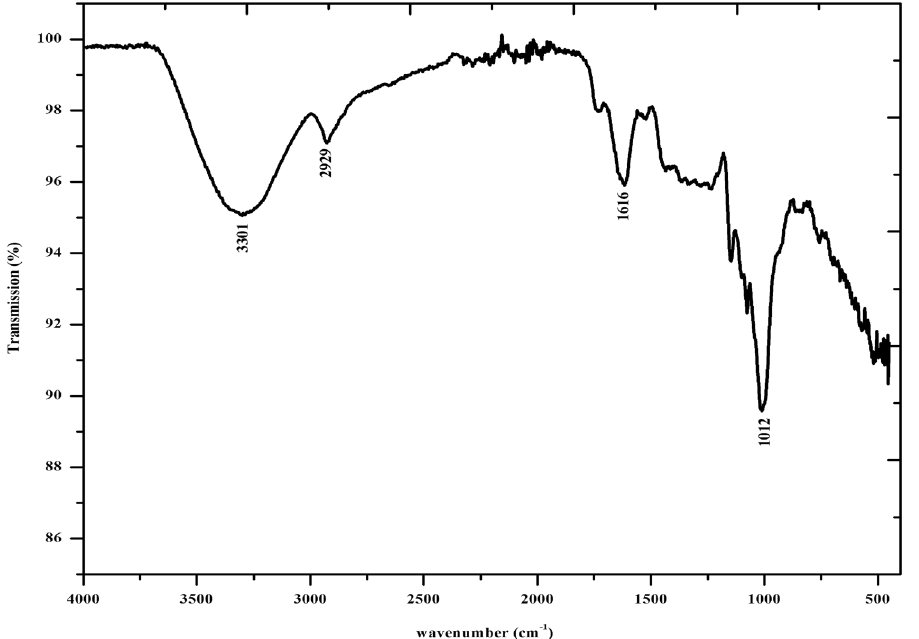
Figure 6. FTIR spectrum of gold nanoparticle.